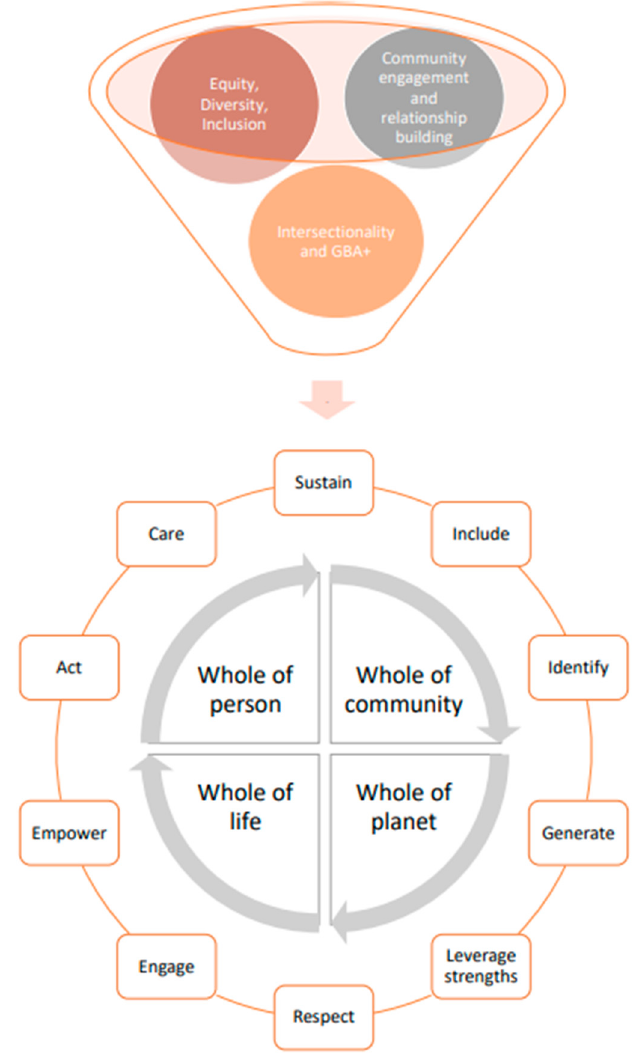
Figure 3. Guiding conceptual framework.